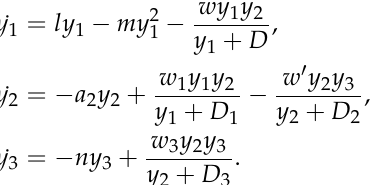
Table 1. Cont. Symbols Description a 1 intrinsic growth rate of prey b 1 measure of competition among prey a 2 intrinsic death rate of x 2 in the absence of food x 1 only D , D 1 measure of the level of protection offered to the prey by the environment D 2 value of x 2 at which its per capita removal rate becomes w 2 /2 D 3 Loss of x 3 due to lack of favorite food x 2 c growth rate of x 3 via sexual reproduction w , w (cid:48) s maximum value that per capital rate can i